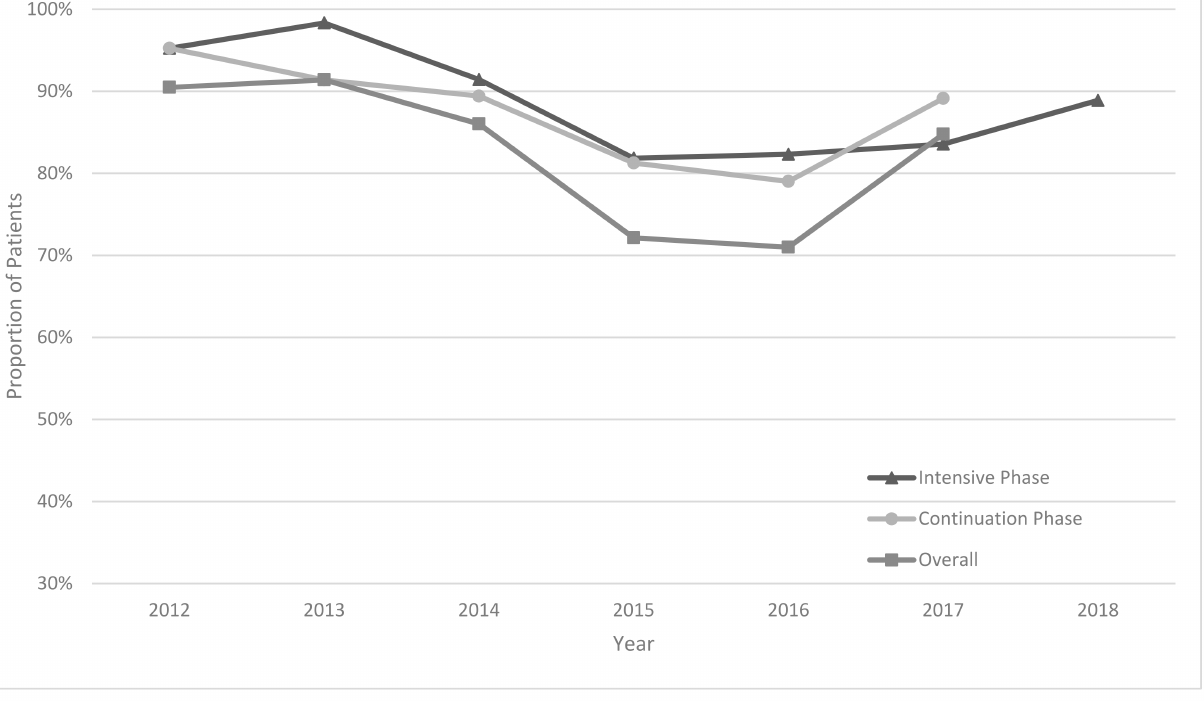
Figure 2. Percentage of patients compliant to weight-based drug dosage among MDR/RR-TB patients registered from 2012 to 2018 in Uzbekistan and assessed under the project of “Evaluation of the TB drug usage for treating MDR